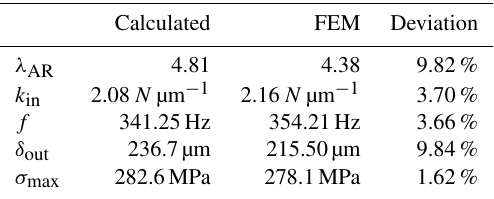
Table 2. Comparison results between calculated values and simu- lated values.